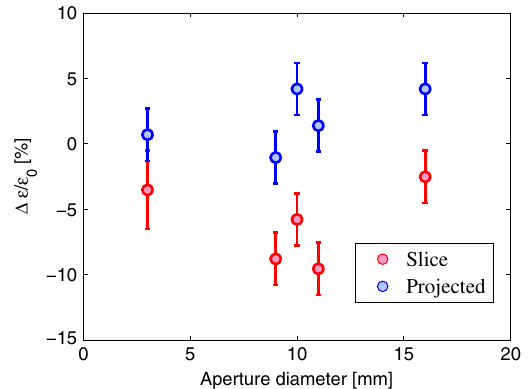
FIG. 21. Measured projected emittance increase versus the hole diameter of the collimator normalized to the case with the collimator removed from the beam path. The slice emittance of the central slice along the longitudinal coordinate of the bunch is reported for comparison to give an idea of the jitter of the